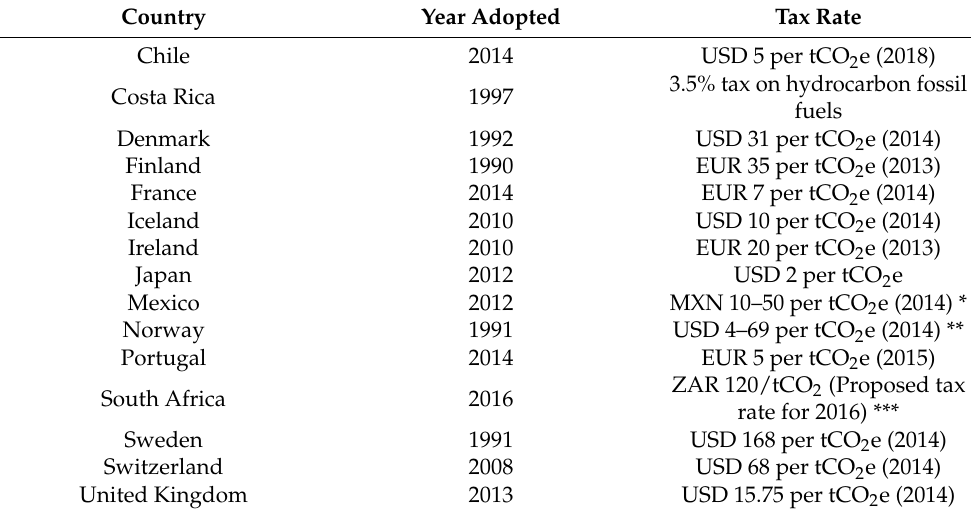
Table A1. Carbon tax schemes in various